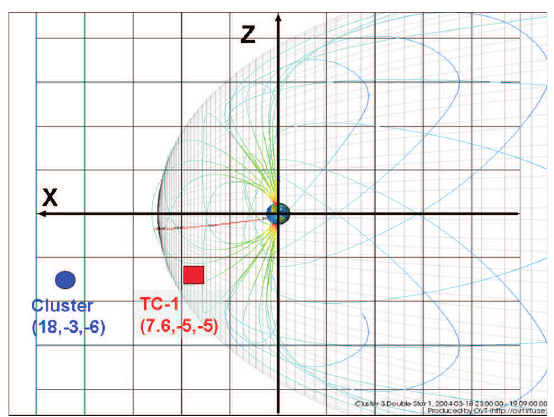
Fig. 1. The locations of TC-1 and Cluster spacecraft from 23:10 to 23:50 UT on 18 March 2004. The shape of the magnetosphere is produced by OVT (http://ovt.irfu.se).